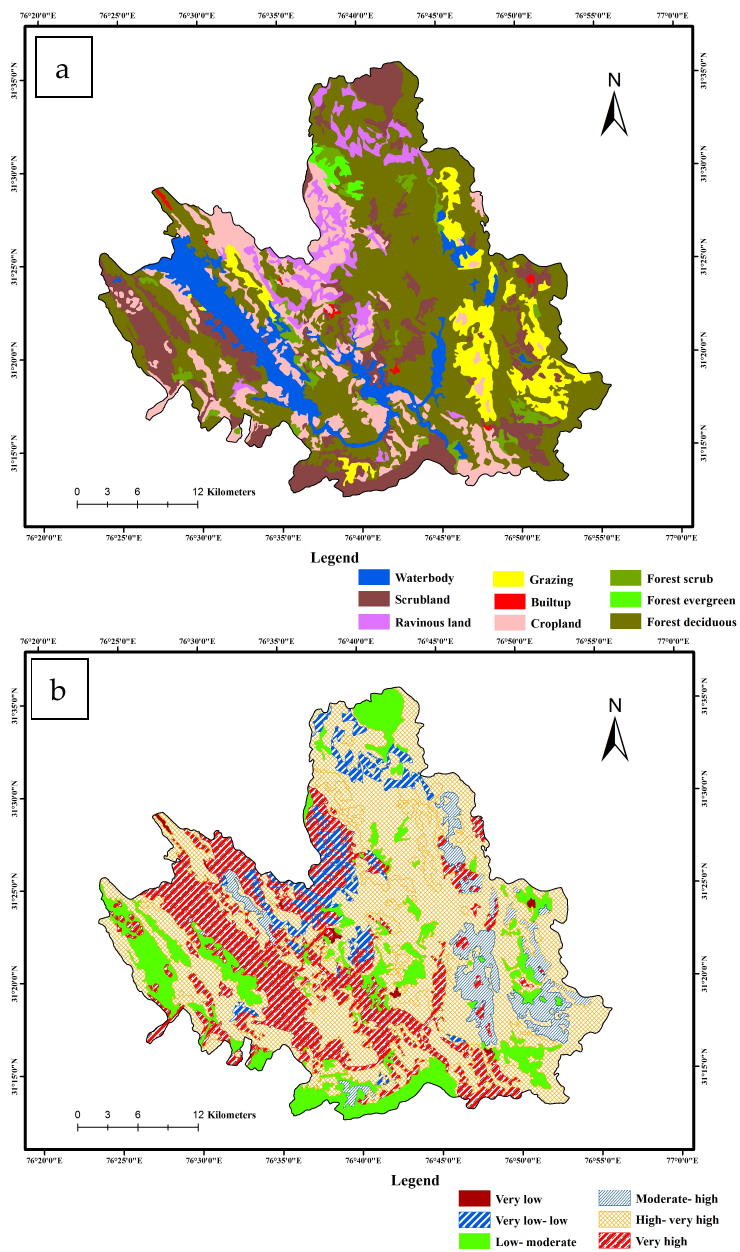
Figure 6. ( a ) Land use/land cover map of Bilaspur district; ( b ) LU/LC index map of Bilaspur district.